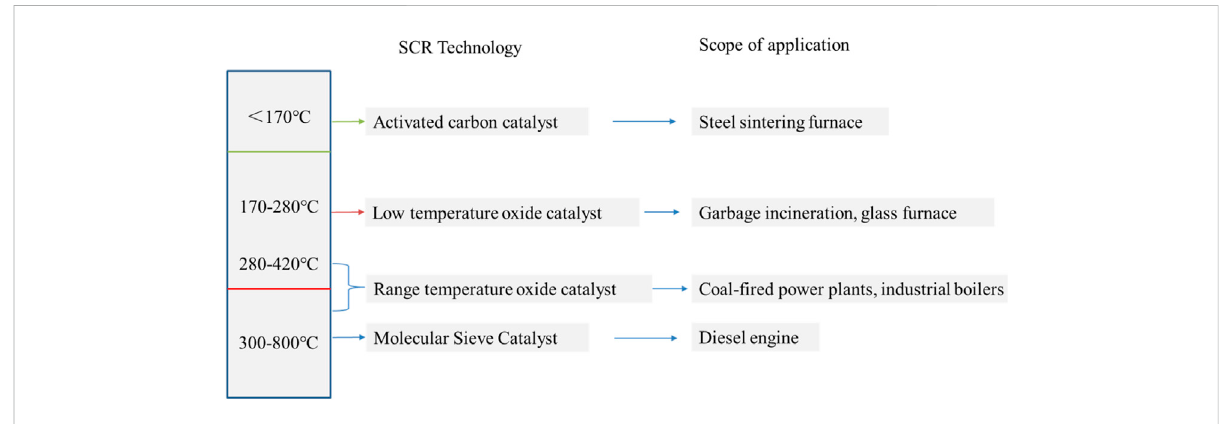
FIGURE 2 SCR technology route for controlling nitrogen oxide